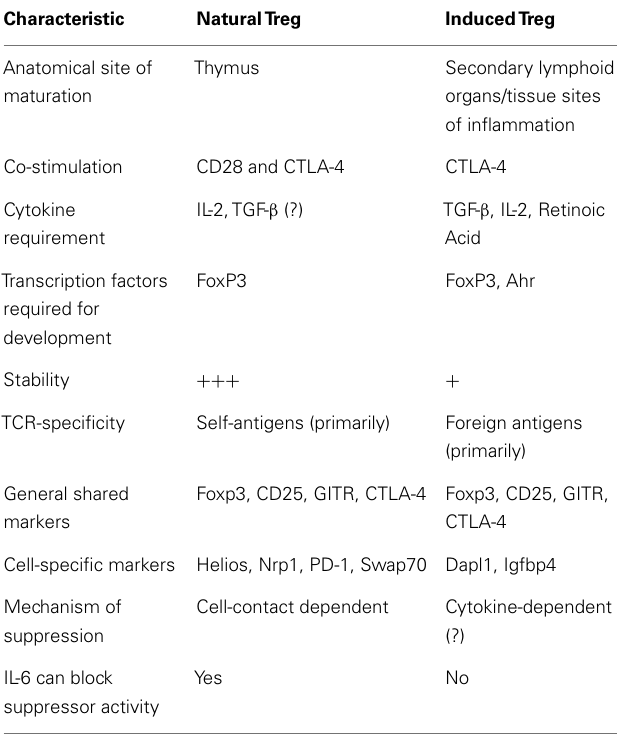
Table 1 | Characteristics that distinguish nTreg from